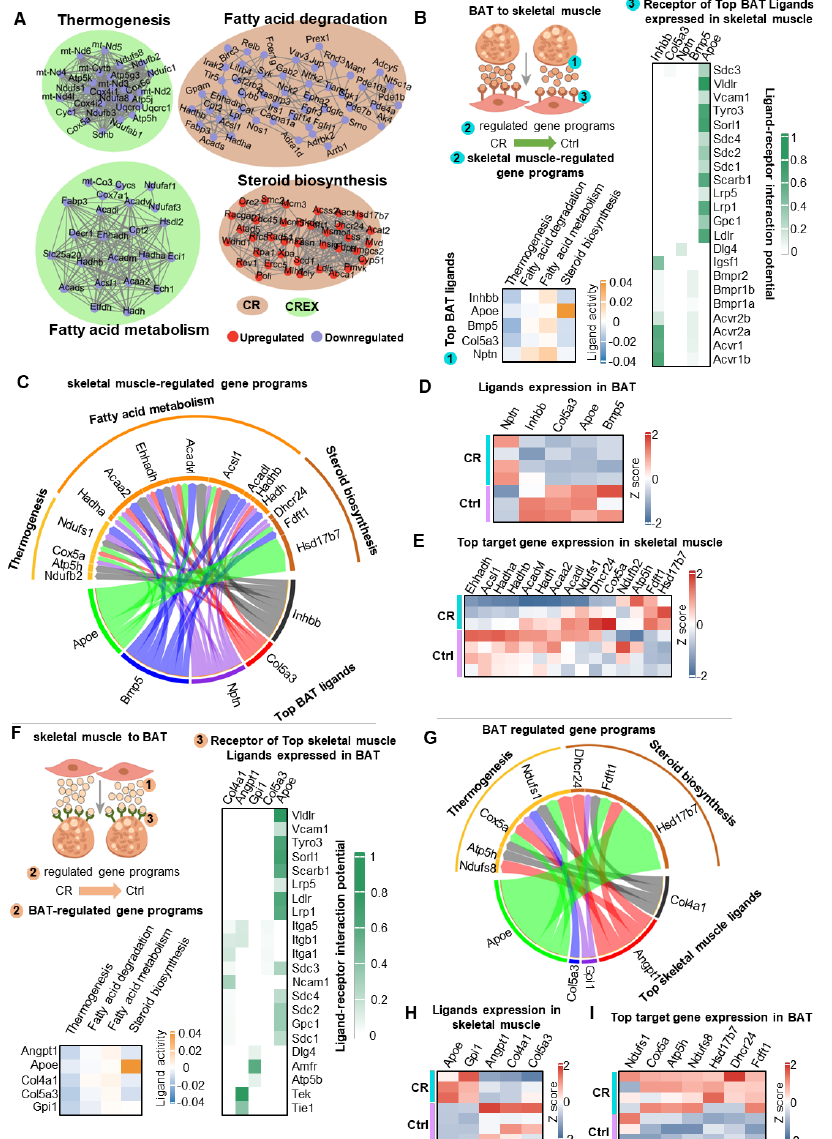
Figure 7. The crosstalk between BAT and muscle. ( A ) Gene networks for selected DEGs from the two tissues that encoded interacting proteins clustered by MCODE, with each cluster named according to the most significantly enriched pathway. The clusters are colored according to the DEG direction and tissue category. ( B ) NicheNet workflow (left top), the activity of the top five putative BAT ligands (left bottom) and the interaction potential for the putative receptors of the top five BAT ligands in skeletal muscle (right). ( C ) Predicted interactions between BAT ligands and their predicted skeletal muscle target genes associated with the indicated KEGG pathways. ( D , E ) Expressions of the genes encoding the top five predicted upstream ligands in BAT ( D ) and of their top target genes in skeletal muscle related to the indicated KEGG pathways ( E ). ( F ) NicheNet workflow (bottom), the activity of the top five putative skeletal muscle ligands (bottom) and the interaction potential for the putative BAT receptors (right). ( G ) Predicted interactions between skeletal muscle-derived ligands and their predicted BAT target genes belonging to the indicated KEGG pathways. ( H , I ) Expressions of the genes encoding the top five predicted ligands in skeletal muscle ( H ) and of their top target genes in BAT associated with the indicated KEGG pathways ( I ).